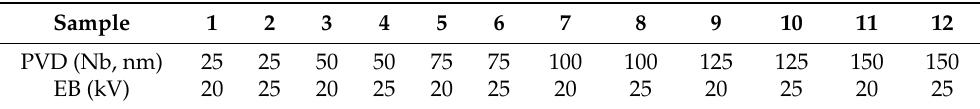
Table 2. Alloying parameters for samples of set I.